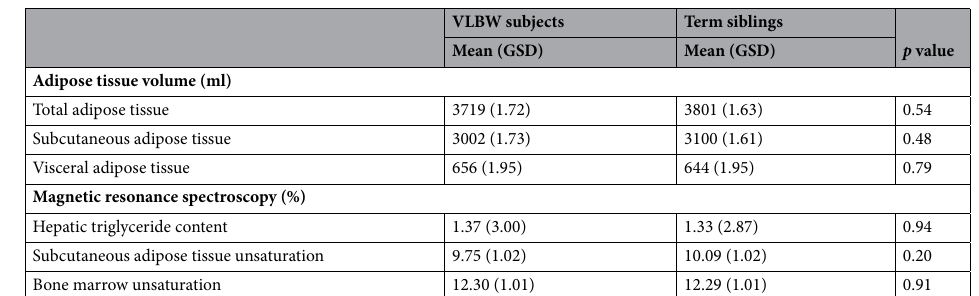
Table 2. Abdominal adipose tissue volumes, liver fat, and fat unsaturation in the VLBW and term-born sibling control groups. VLBW: very low birth weight (< 1500 g). Numbers represent geometric means and standard deviations. p values for differences between VLBW subjects and controls calculated with paired samples t-tests. Abdominal adipose tissue pool volumes are presented in millilitres, hepatic triglyceride content is presented as the ratio between the sum of T2- and PD-corrected methylene and water resonances in the liver, and subcutaneous and bone marrow unsaturation are presented as the ratio between the double bond and methylene resonances in subcutaneous adipose tissue and proximal tibial bone marrow,